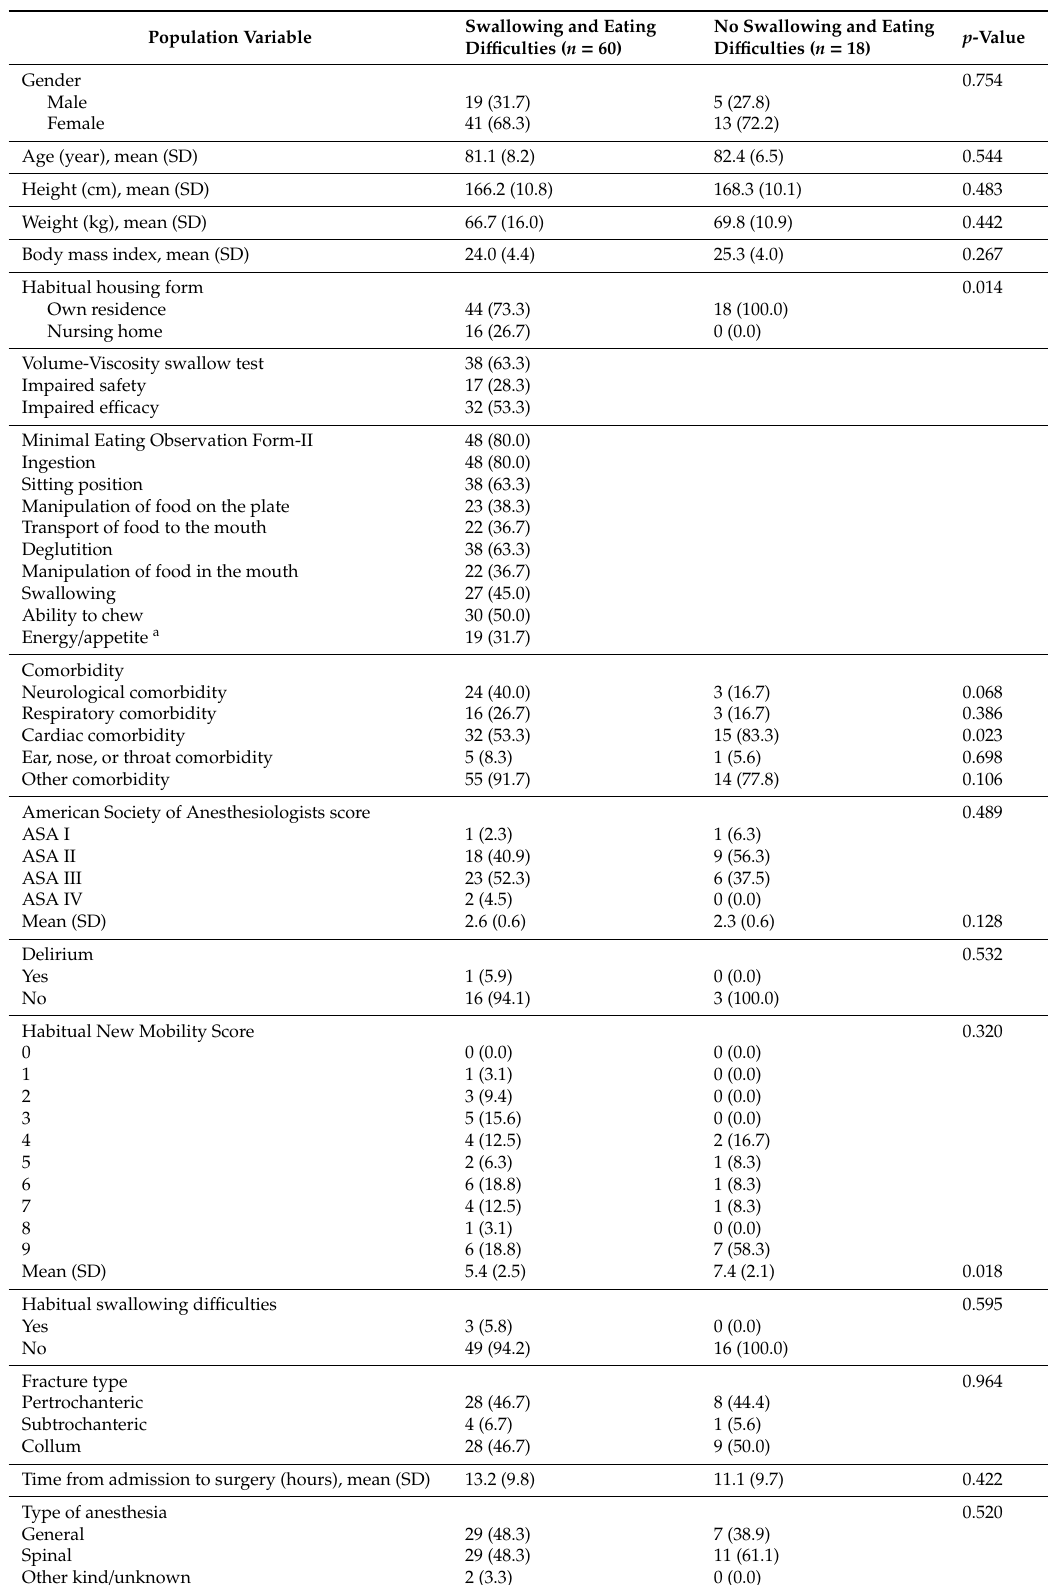
Table 2. Comparison of baseline demographics and clinical characteristics of patients with and without swallowing and eating di ffi